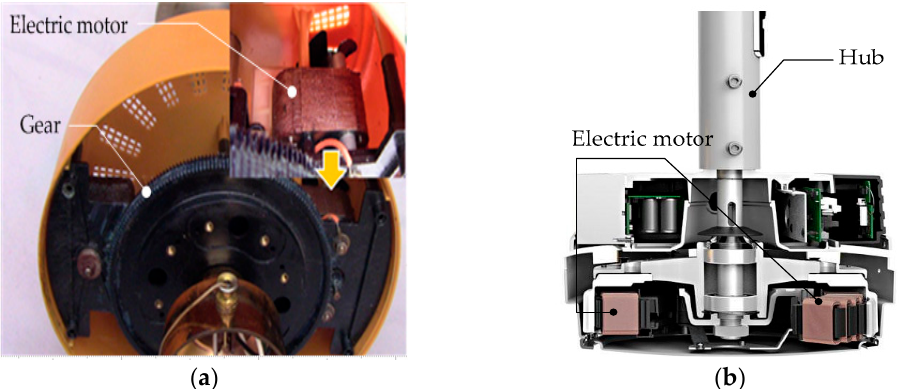
Figure 8. Monstrous fan driving mechanism ( a ) Geared mechanism ( b ) Gearless